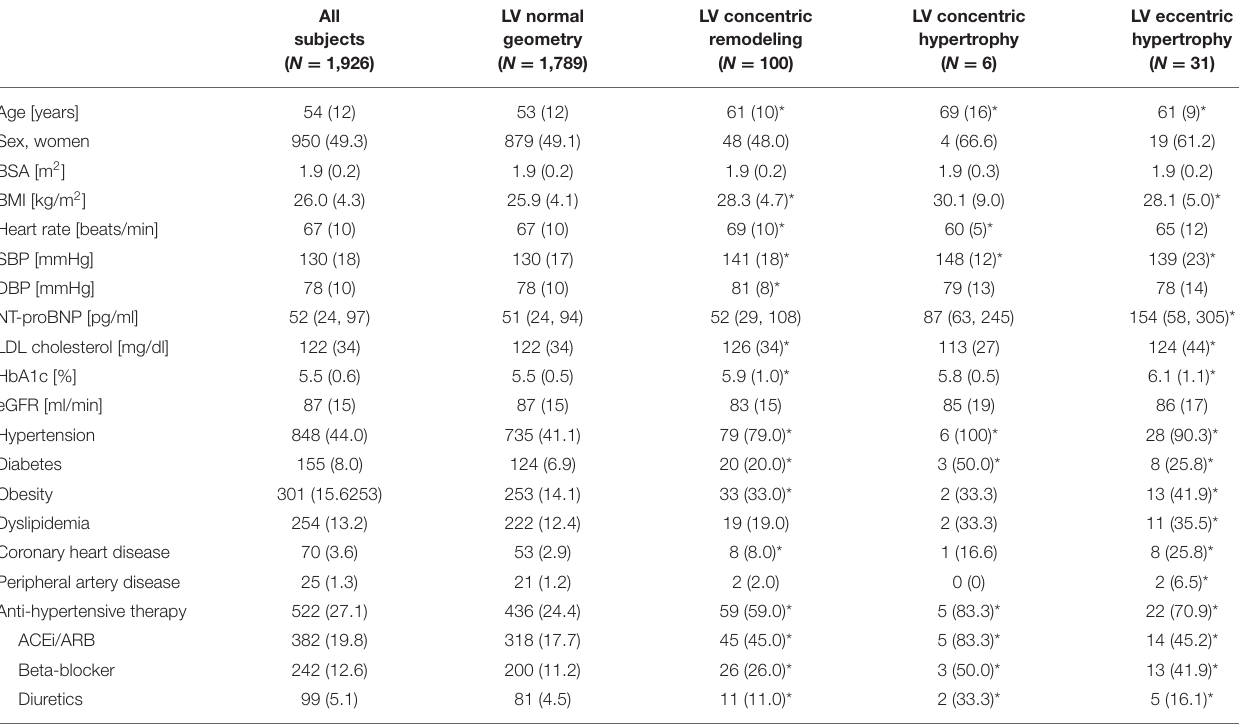
TABLE 1 | Baseline characteristics in the total sample and according to left ventricular (LV) geometry.